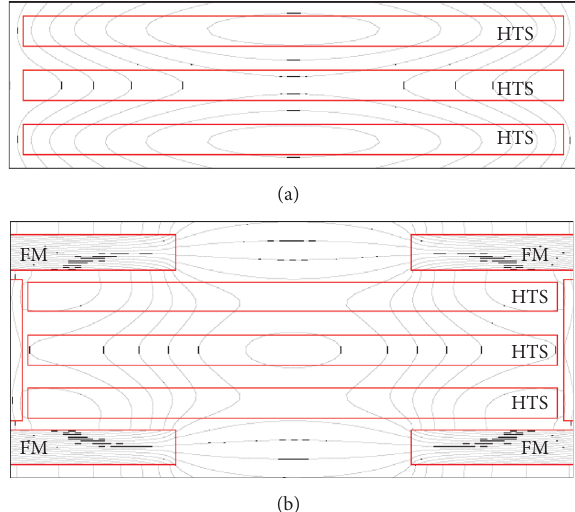
Figure 10: Calculated magnetic flux lines by finite element method ANSYS code [9] for three-layer stacked tape conductors (a) without FMLs and (b) with FMs at the edges under the antidirection ( ↑↓↑ ) current feeding mode. The currents in each tape are 𝐼 1 = −𝐼 2 = 𝐼 3 = 200 A as in Figure